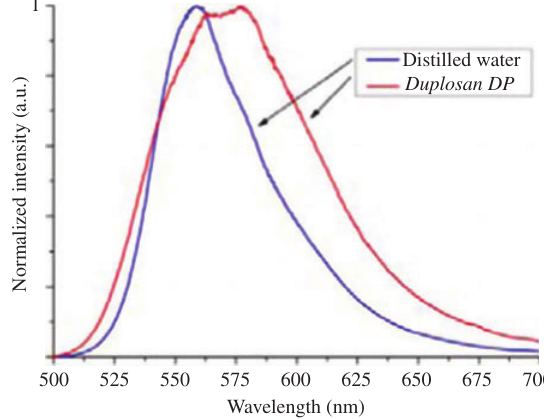
Figure 18 Fluorescence intensity of rhodamine 6G layer on ivy leaf surface applied with distilled water and with Duplosan DP . Measurement was performed using a LIF system (excitation at 337 nm) ( Hake et al. 2007